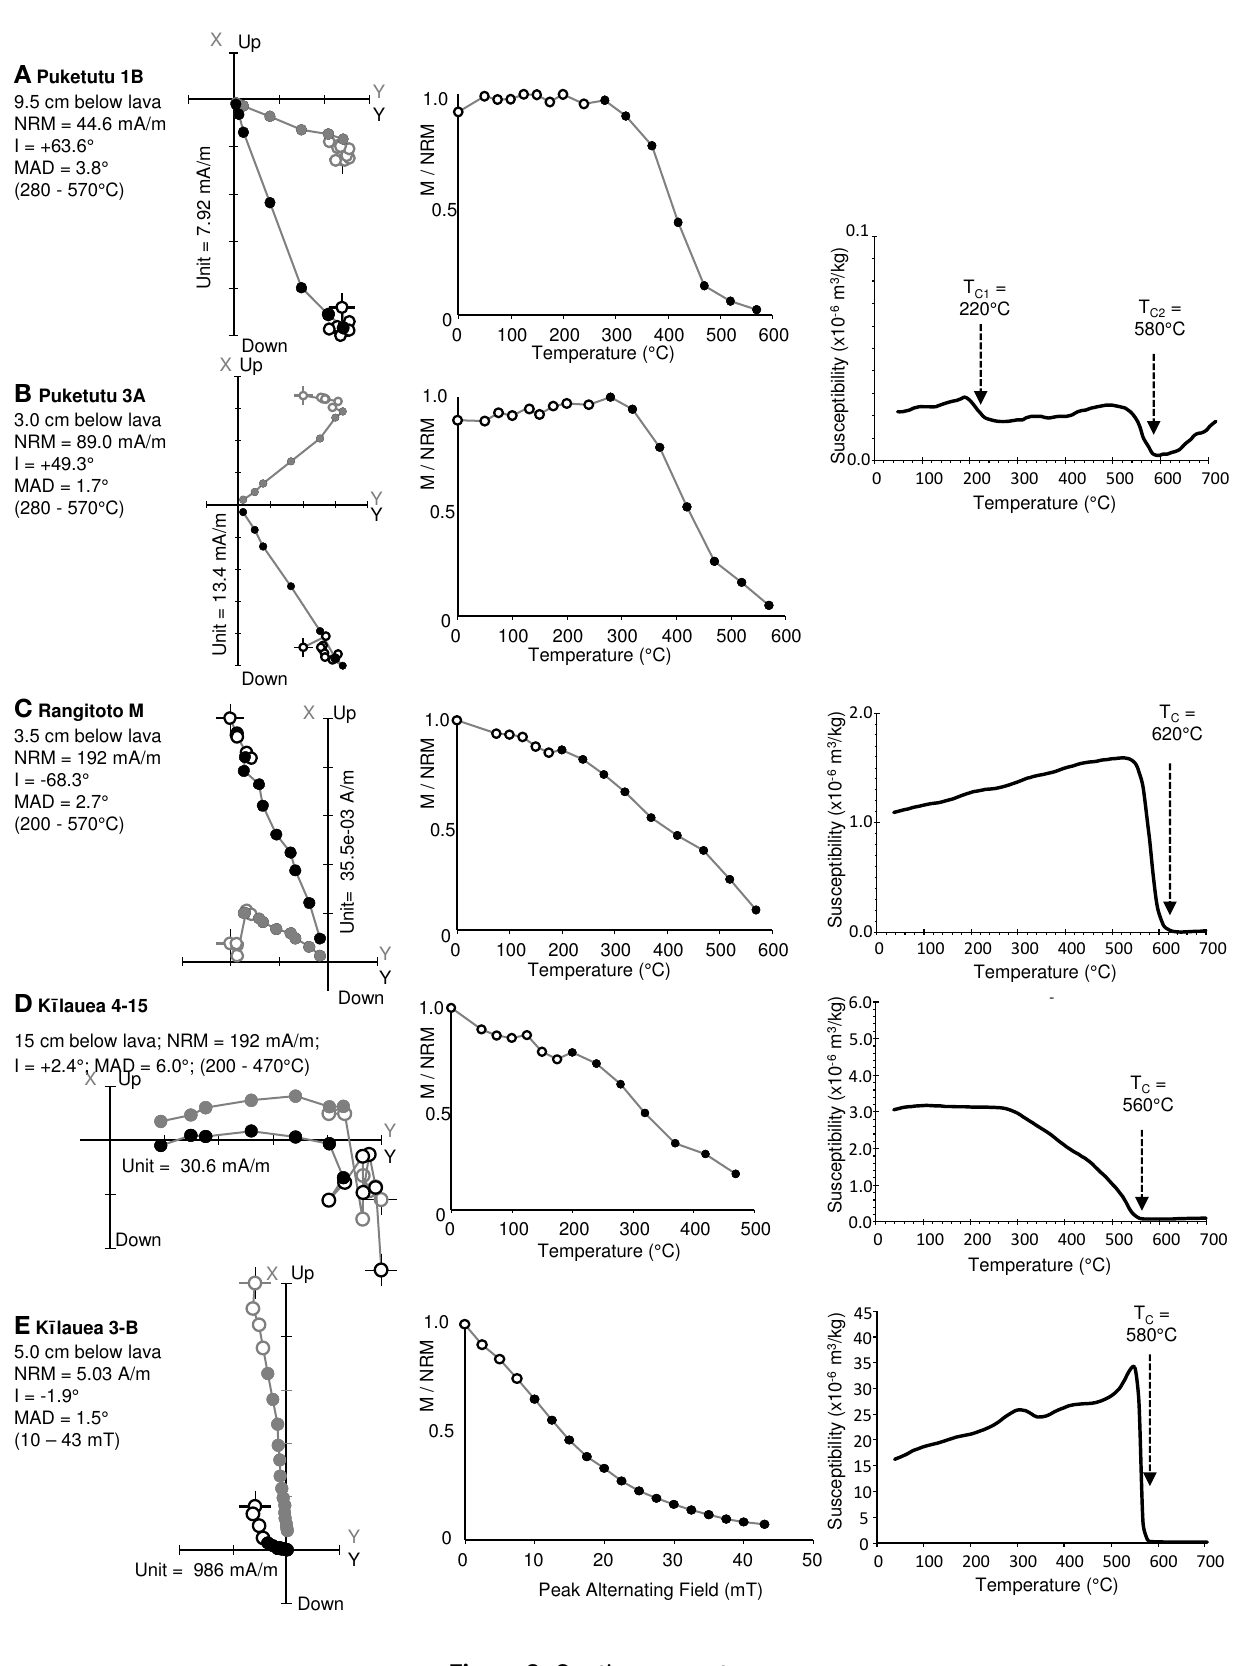
Figure 2: Caption on next